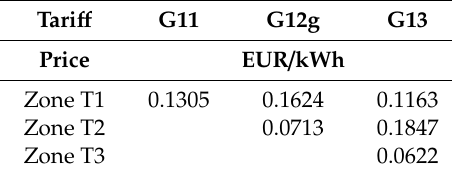
Table 9. Cost of energy in selected tari ff s in Poland in 2019.